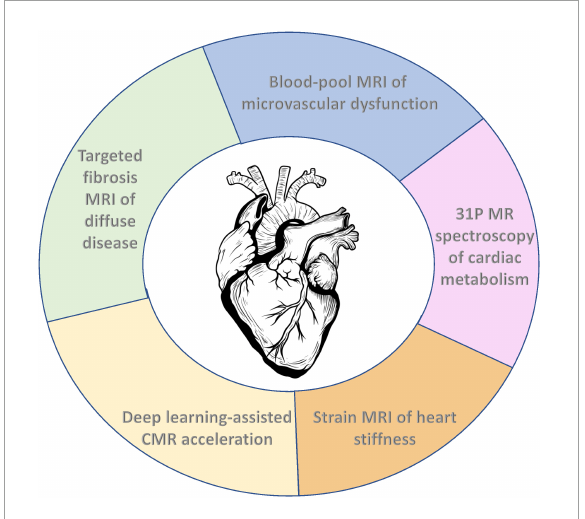
FIGURE1 Emerging cardiac MRI (CMR) techniques for molecular and functional characterization of the diseased